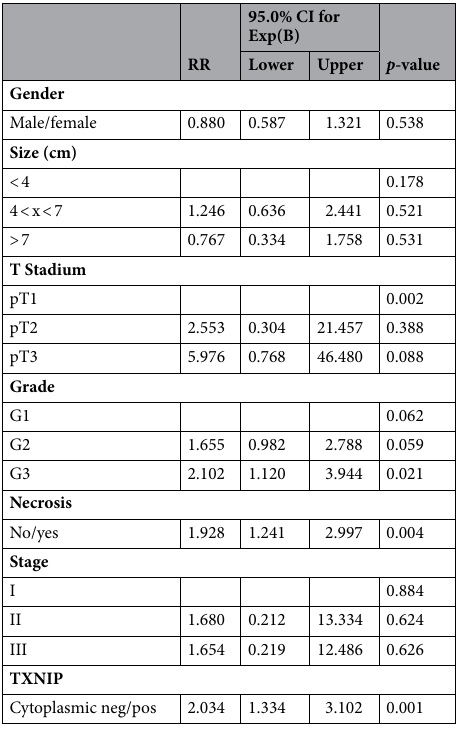
Table 2. Multivariate analysis of positive TXNIP expression in 691 conventional